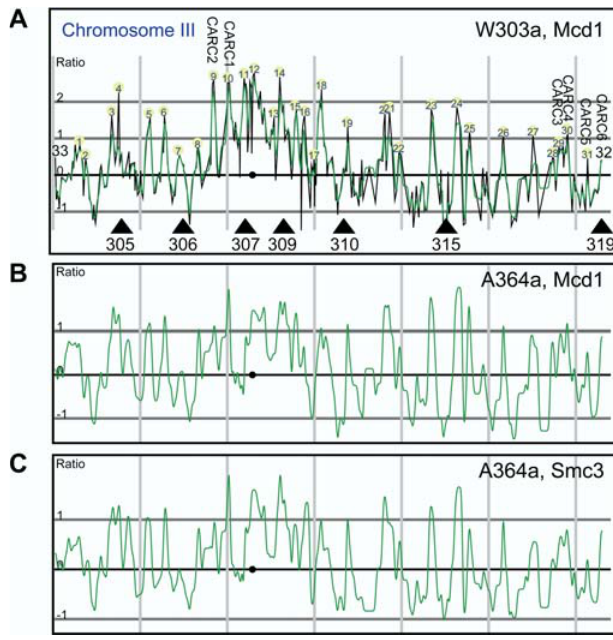
Figure 1. Interactions between Cohesin and CHRIII in S. cerevisiae The centromere is indicated with a black circle; the smoothed data are indicated with a green line. 50-kb intervals are indicated by vertical grey lines. (A) Data generated from a cdc16 -arrest ChIP for Mcd1-18Myc in W303a. The midpoint of each feature is used to represent the log 2 of the median red:green ratio (left y-axis) with a black line, high firing replication origins are indicated with black triangles, and previously mapped CARC2, CARC1, CARC3, CARC4, CARC5, and CARC6 (Laloraya et al., 2000) correspond to peaks 9, 10, 29, 30, 31, and 32, respectively. Peaks are located and numbered by PeakFinder (with the exception of telomeres) using the parameters described in the Materials and Methods. (B) Smoothed data from cdc16 -arrest ChIP for Mcd1/Scc1-6HA in A364a. (C) Smoothed data from cdc16 -arrest ChIP for Smc3-6Myc in A364a. DOI: 10.1371/journal.pbio.0020259.g001